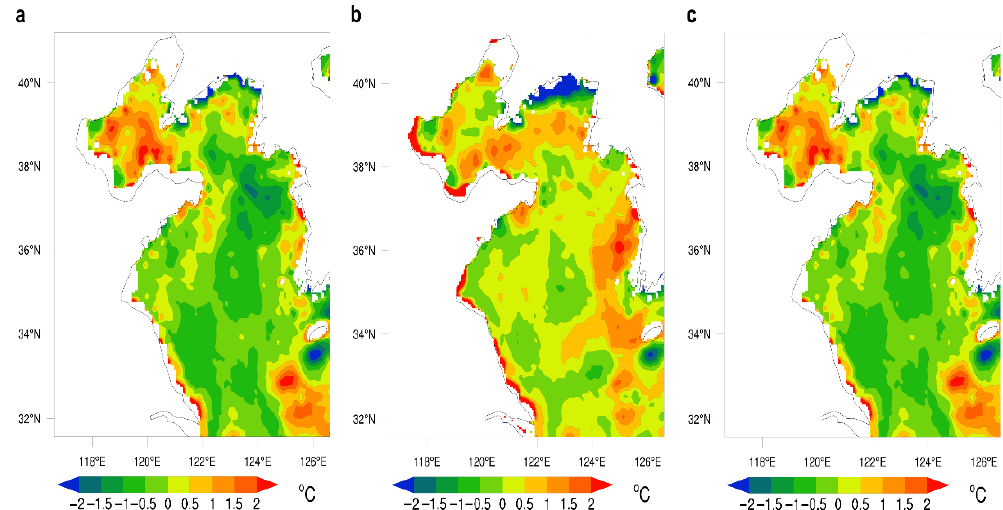
Figure 12. Distribution of the sea surface temperature difference obtained with three schemes at 00:00 UTC on 20 February 2020. ( a ) Difference between CODAS 6h and CODAS daily SST; ( b ) difference between CODAS 6h SST and FNL SST; ( c ) Difference between CODAS daily SST and FNL SST.